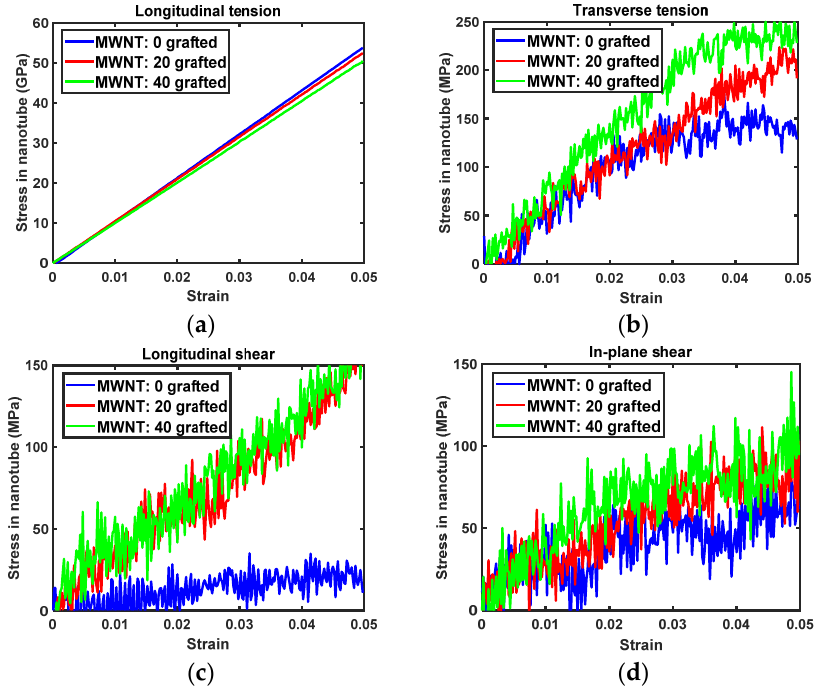
Figure 9. Stress evolution of MWNTs in nanocomposites, specifically the ( a ) longitudinal tension, ( b ) transverse tension, ( c ) longitudinal shearing, and ( d ) in-plane shearing. ( b ) transverse tension, ( c ) longitudinal shearing, and ( d ) in-plane